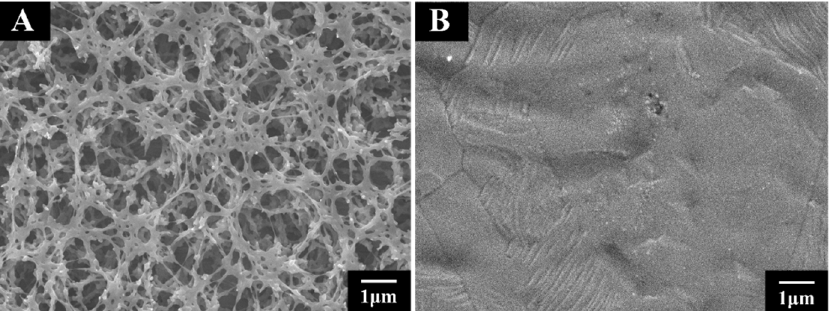
Figure 1. SEM images of ( A ) as-deposited coatings and ( B ) coatings annealed at 200 °C for 1 h, prepared from 20 g L − 1 PEMA solutions.